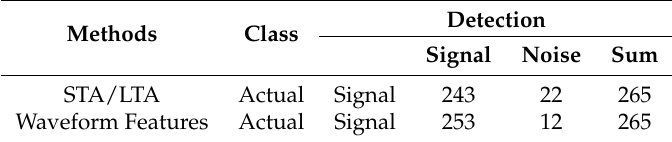
Table 7. Test results of KSRS array data in